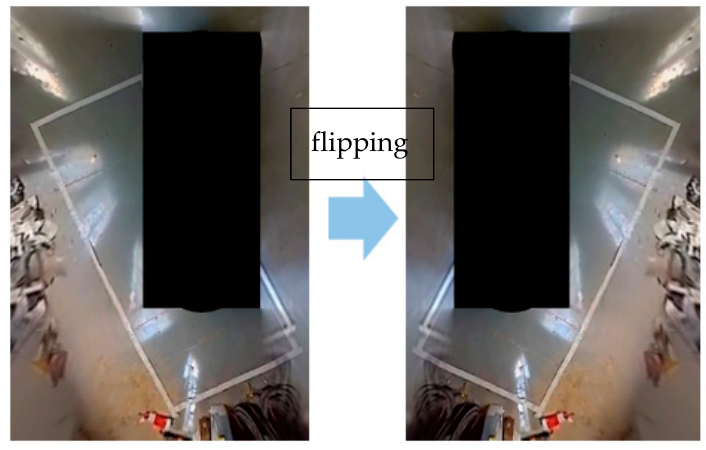
Figure 9. Flip picture